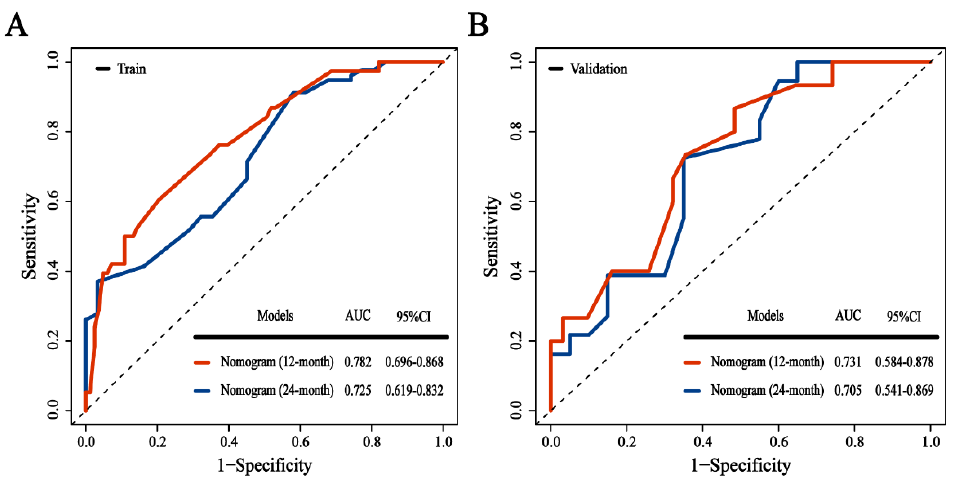
Figure 5. Performance comparison of the Nomogram Score. ROC curve in training ( A ) and validation cohort ( B ). ROC , receiver operating characteristics; AUC , area under the ROC; CI , confidence interval.